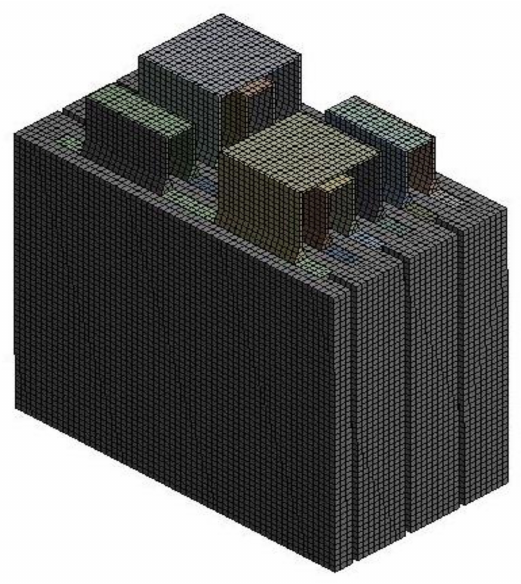
Figure 4. Final mesh of 3S2P LIB with enclosure, which consists of 142,683 hexahedral